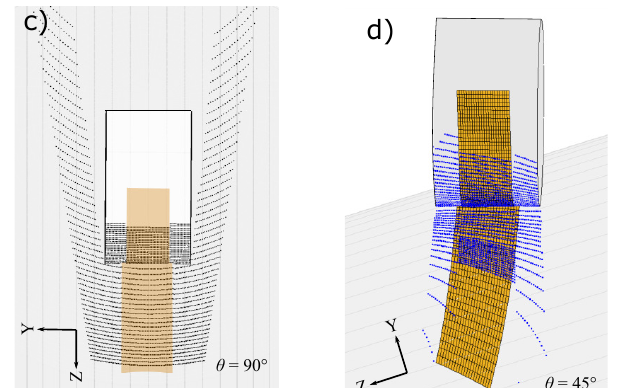
Figure 4. Intersection of the incoming rays with the mandrel, the tape, the substrate and roller for ( a ) θ = 0 ◦ , ( b ) θ = 45 ◦ and ( c ) θ = 90 ◦ . ( d ) The corresponding intersection of the reflected rays for θ = 45 ◦ . The rays were discretized uniformly along the length and width of the laser source plane.